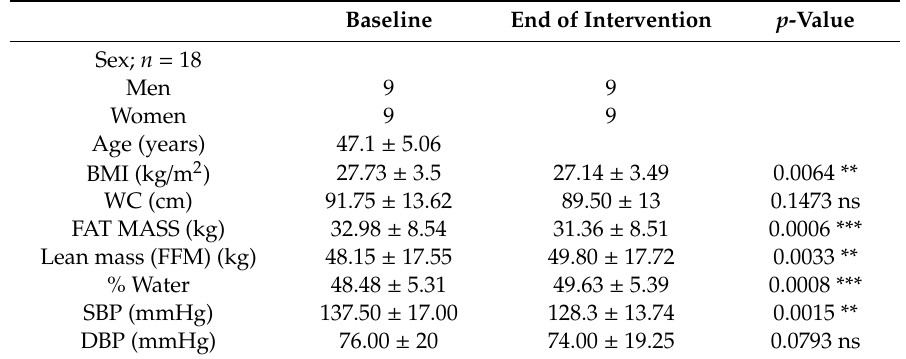
Table 5. Changes in parameters of body composition and blood pressure (at the baseline and after the dietary intervention) in study participants.